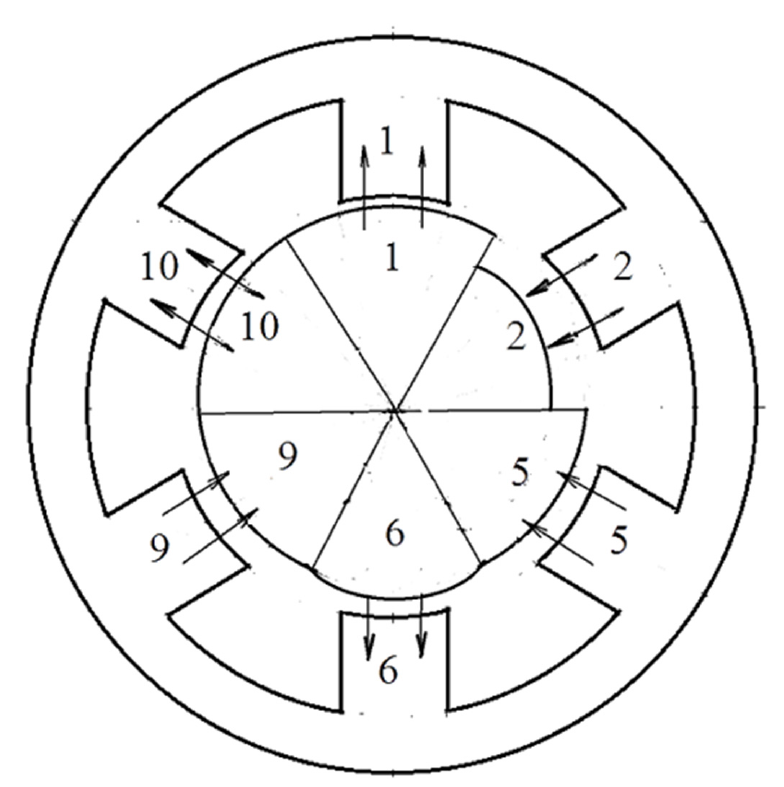
Figure 3. Determination of the magnesium conductivity of the air gap with a fixed position of the rotor.